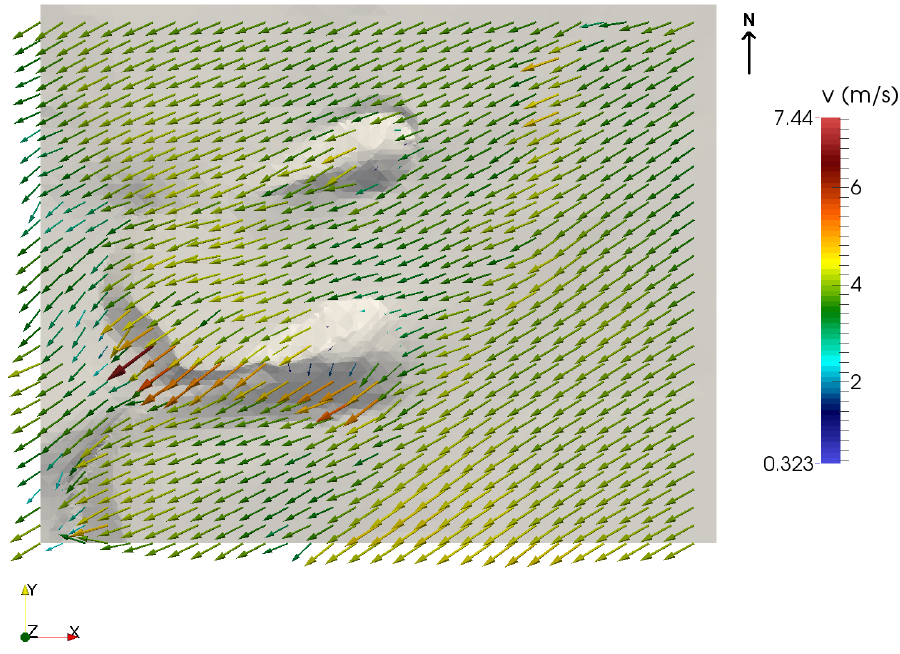
Figure 15. A view of the resulting wind field near the terrain